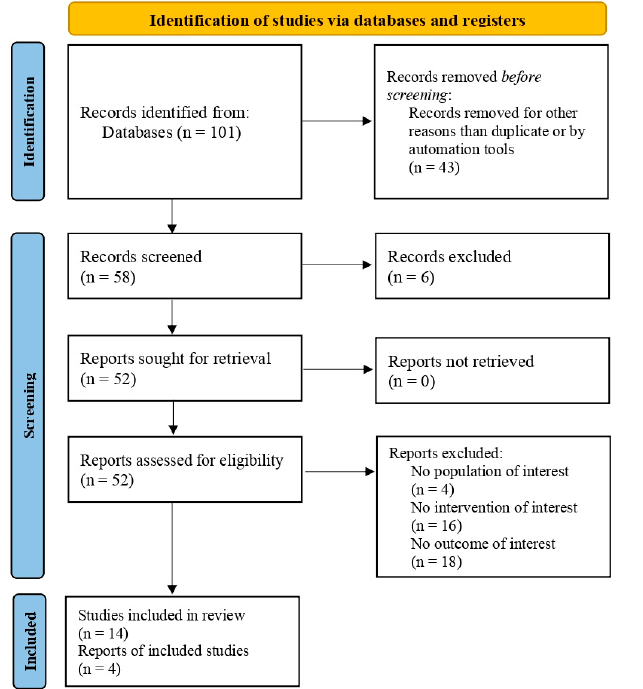
Figure 1. Preferred Reporting Items for Systematic Reviews and Meta-Analyses (PRISMA) diagram. Table 1. Major blood biomarkers in animal studies of vancomycin-induced acute kidney injury.